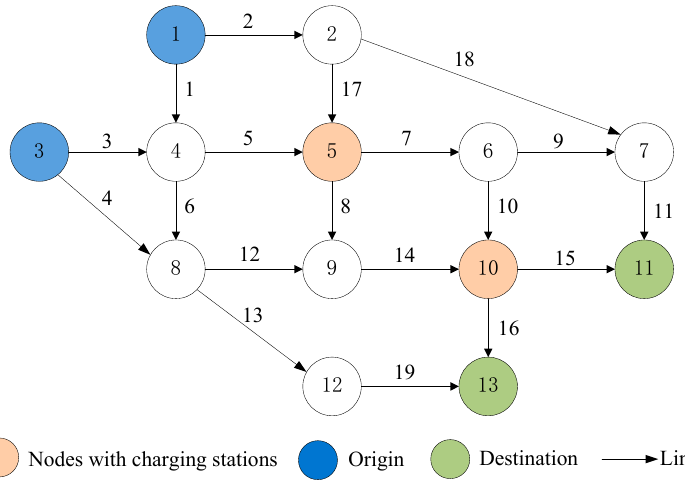
Figure 2. Nguyen–Dupius network. Table 1. Link capacity (veh / h), distance (km) and free-flow travel time (min).